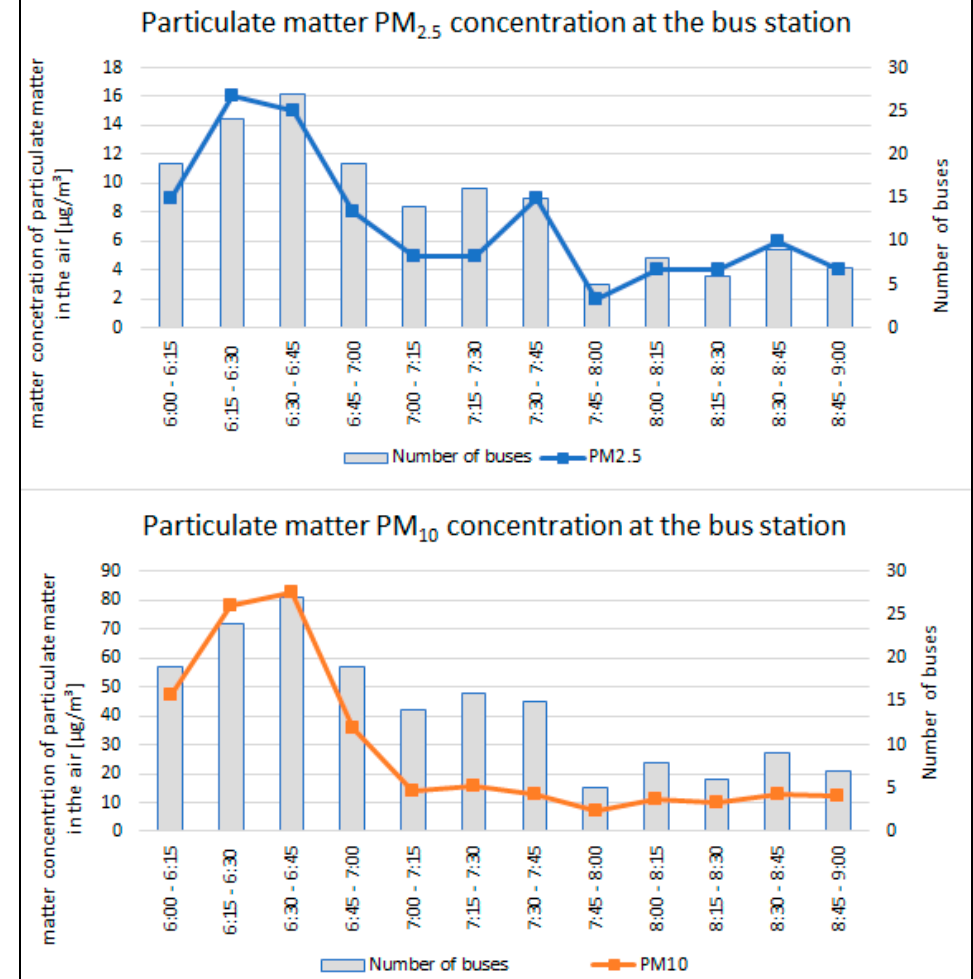
Figure 4. Particulate matter concentration at bus station.